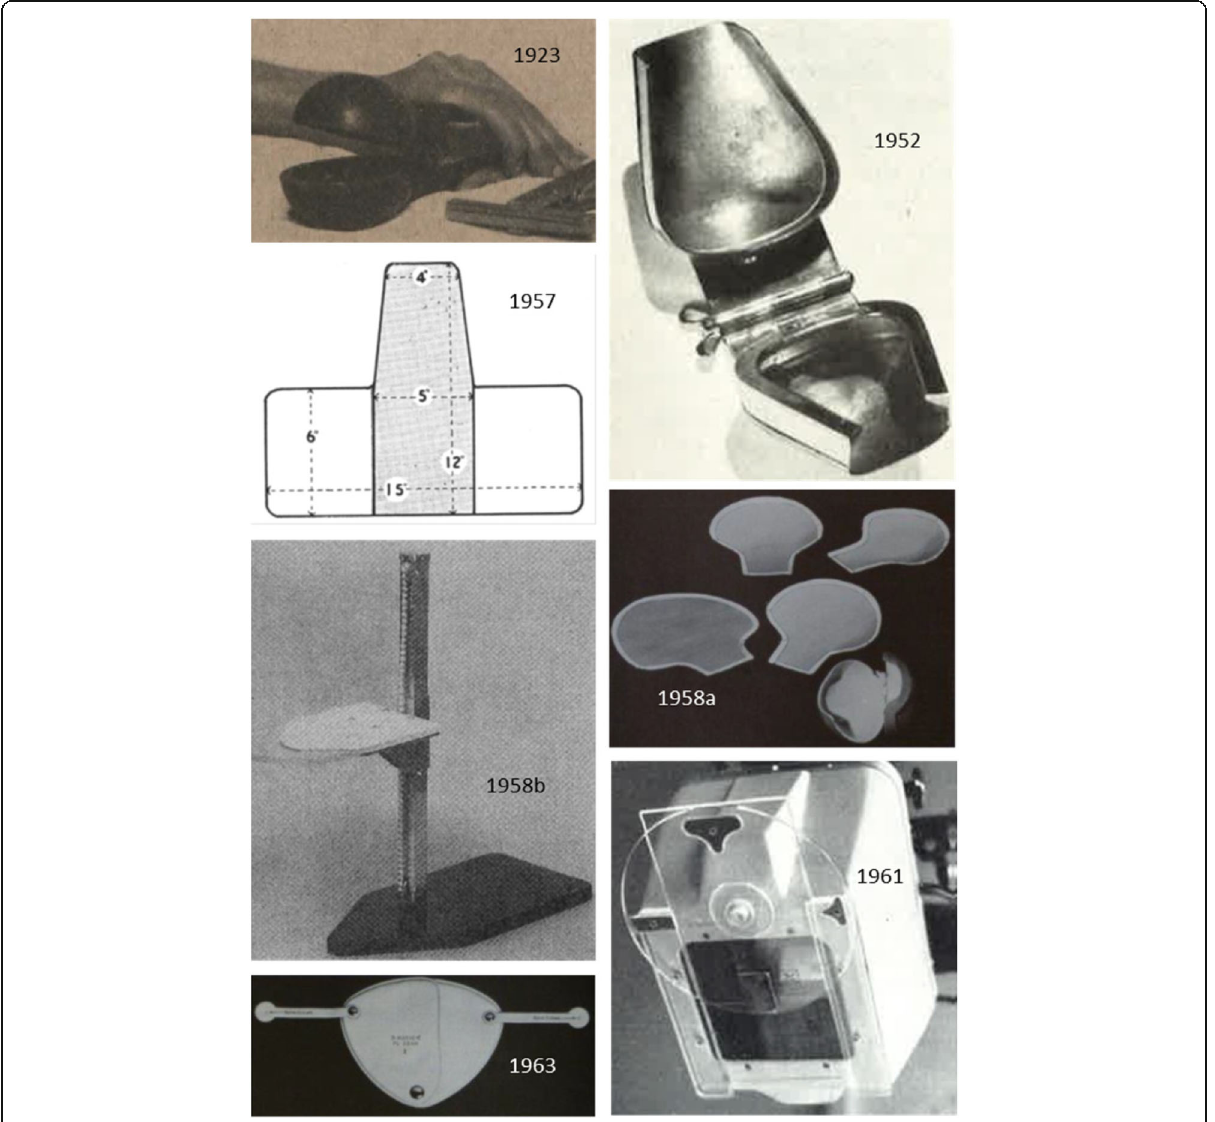
Fig. 1 Some early gonad shields with the year they were described in the literature. Testes capsules are seen on the photographs from 1923 [45], 1952 [46] and 1958a (at the right bottom of the image) [47]. A PMMA T-shaped board with 2-mm lead (shaded) for testes shielding is shown on the 1957 drawing [48]. Flexible contact-type shields for females are seen on the 1958a [47] and 1963 [55] images. The devices on the photos from 1958b [52] and 1961 [53] are of the projection type, the first to be positioned somewhere above the patient and the latter was fixed to the X-ray diaphragm